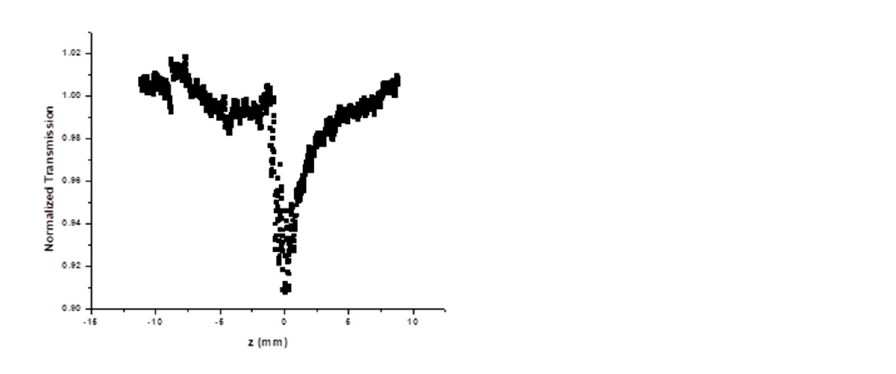
Table 1. Absorption (  ), nonlinear refractive index ( n 2), and nonlinear absorption (  ) values for colloidal silver nanoparticles.